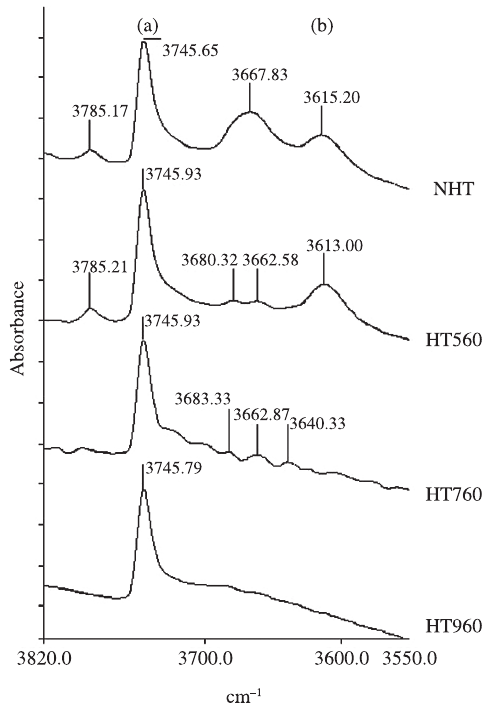
Figure 3. FTIR spectra of O-H stretching vibrations in the region located between 3820 and 3550 cm –1 of the zeolite samples NHT, HT560, HT760 and HT960. a) Silanols (Si-OH) groups. b) Bridged Si-OH-Al